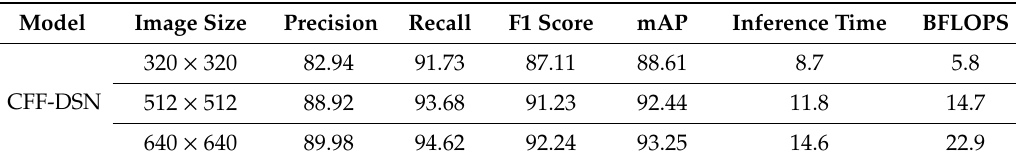
Table 7. Performance of CFF-DSN with different image size.